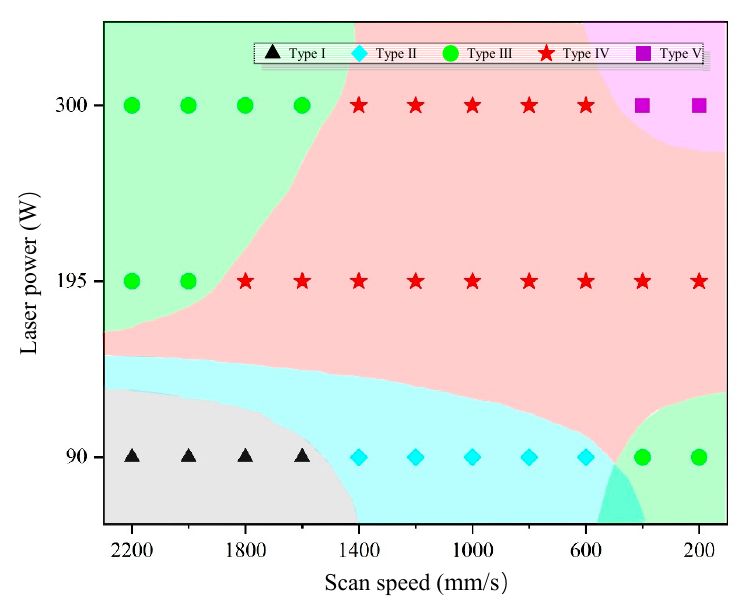
Figure 3. A dot distribution map showing the combinations of laser power and scan speed at which different types of tracks were formed. The base colors are for a clear distinction.